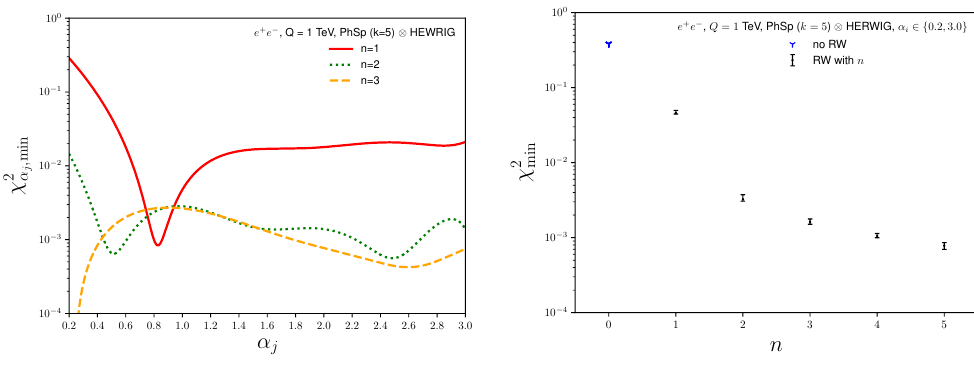
Figure 9 . Same as (cid:12)gure 7 but using 5-body phase space in the